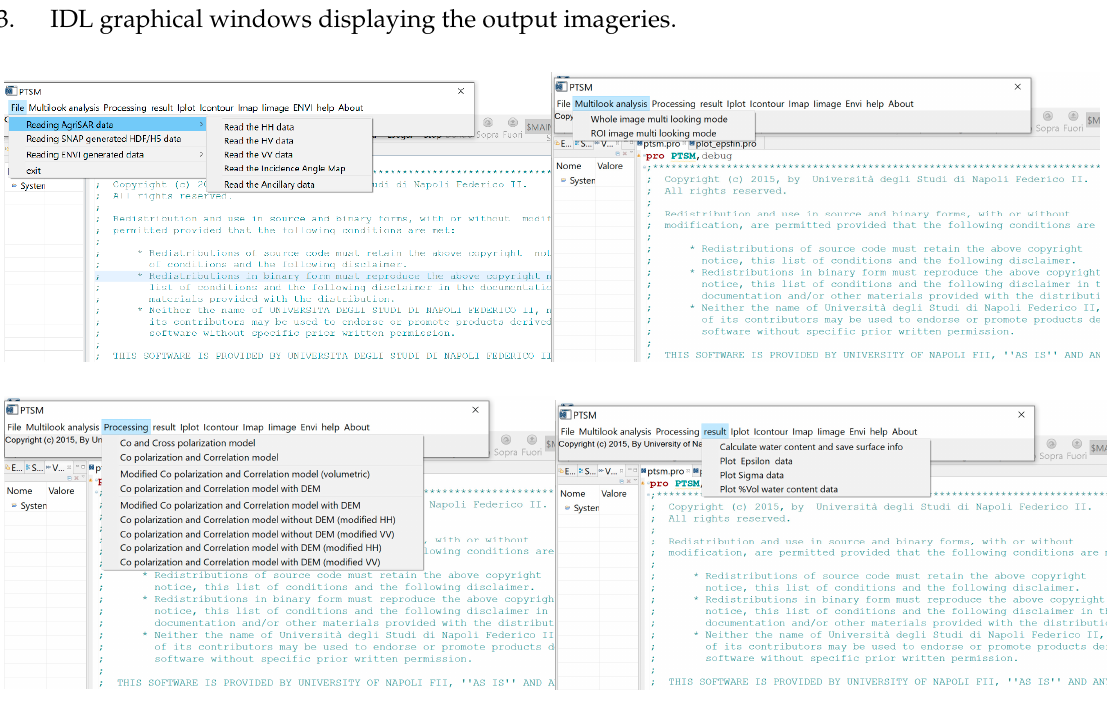
Figure 7. PTSM-OOP’s scrolling list for File, Multilook analysis, Processing and Results.